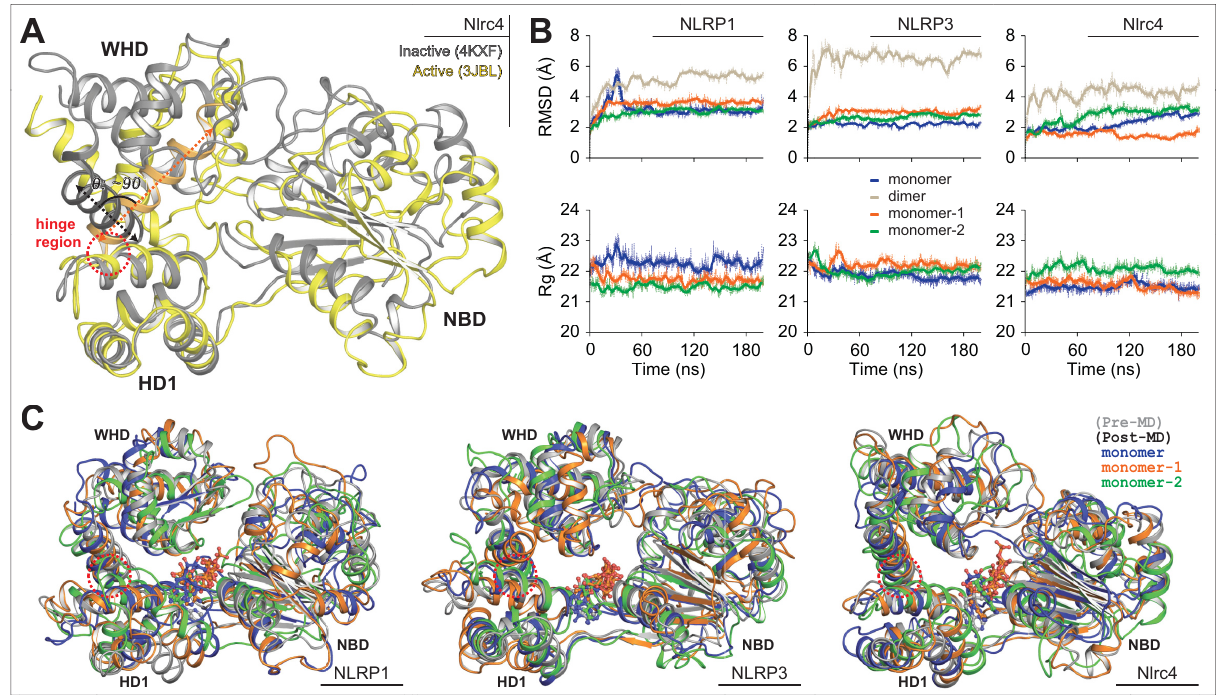
Fig 5. Overview of structural transitions facilitated by NLRP1/3/Nlrc4 NACHT models in response to ATP. (A) Superimposed view of open-close state of Nlrc4 NACHT domain; the inactive/closed structure is displayed in gray cartoon and the active/open state structure is presented in yellow cartoon; the hinge region is marked red circle. (B) Comparative view backbone RMSD and Rg of ATP-Mg 2+ bound NACHT domains in monomeric and dimeric condition. (C) Superimposed view of NLRP/Nlrc4 NACHT models showed structural transitions (pre-MD structures are presented in grey cartoon and post MD structure in colored